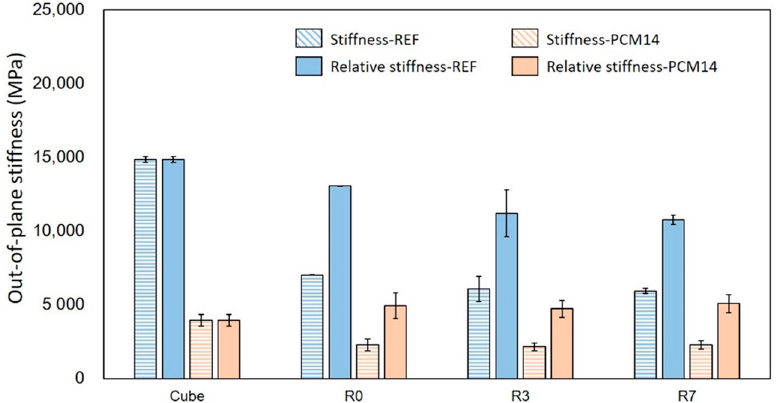
Figure 18. Comparison of the out-of-plane stiffness between R0, R3 and R7 and the material cube stiffness(E-modulus).